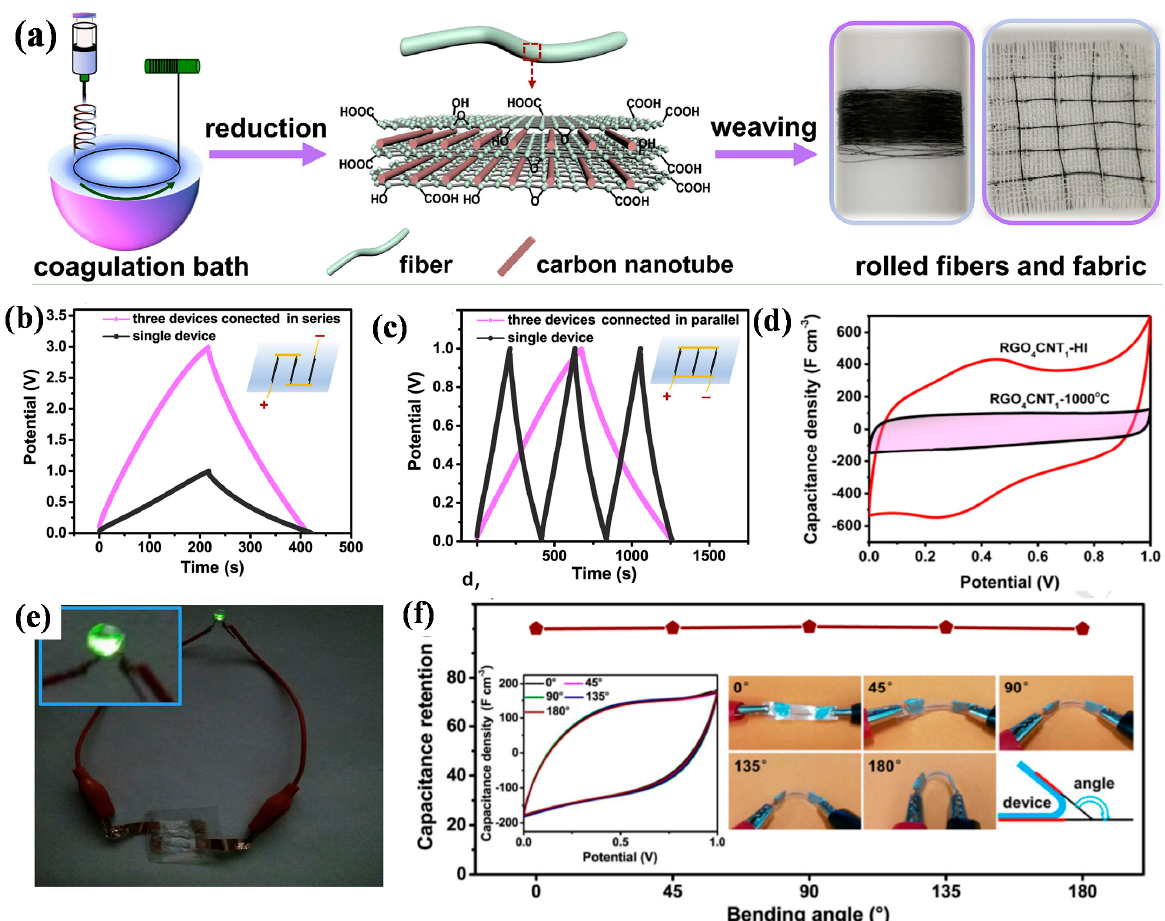
Figure 4. ( a ) Schematic illustrating the preparation of orientated RGO/CNT hybrid fibers, ( b , c ) gal- vanostatic charge/discharge (GCD) curves of single devices and three devices connected in series and parallel, ( d ) CV curves of RGO-CNT-HI and RGO-CNT-1000 °C at a scan rate of 5 mV s − 1 , ( e ) photograph of an LED lit by the supercapacitor, ( f ) capacitance stability at different bending angles. Reproduced from Ref. [115]. Copyrights (Elsevier, 2019).